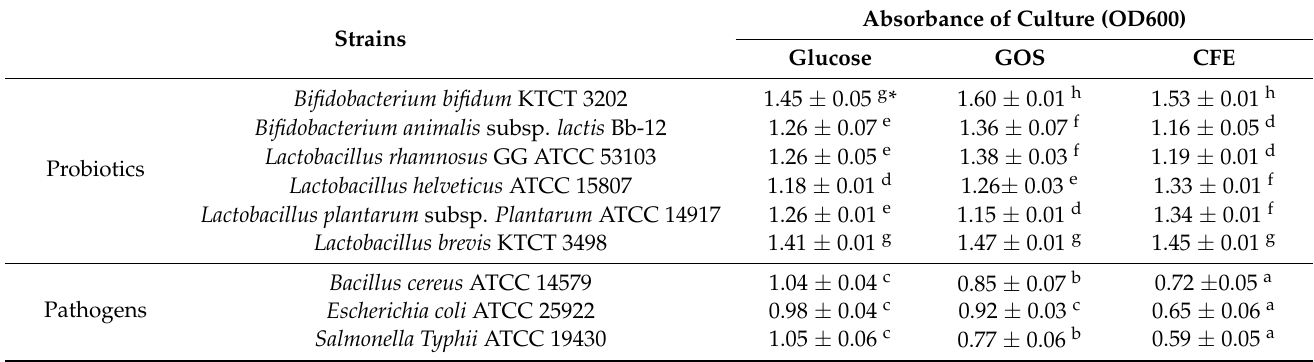
Table 2. Growth (OD600) of probiotics and food-born pathogenic bacteria grown in brain heart infusion (BHI) medium supplemented with CFE.